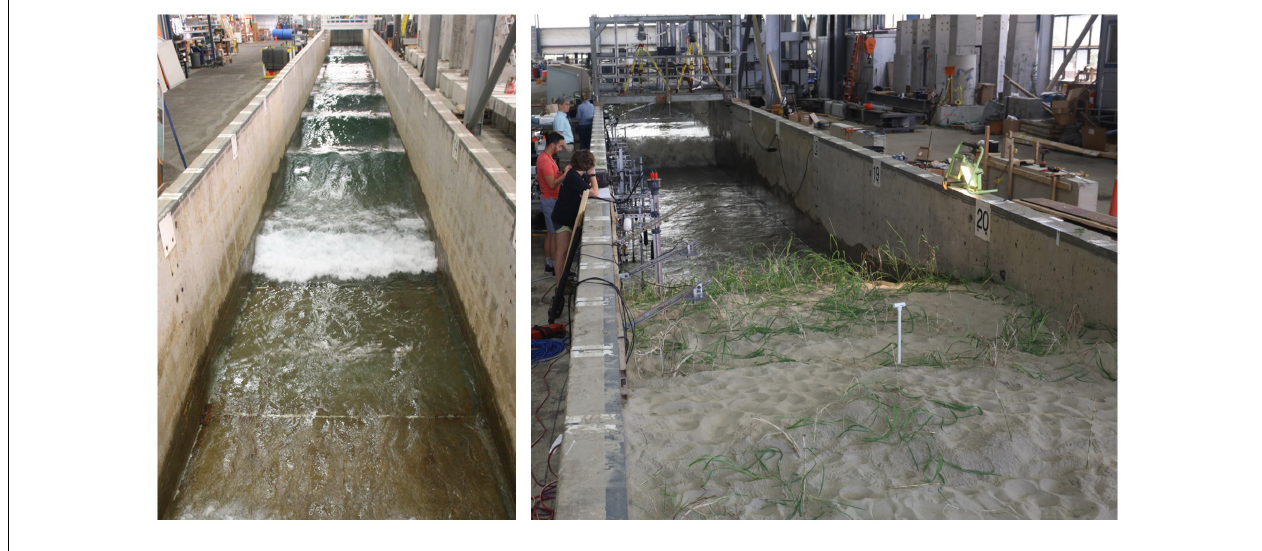
FIGURE 2 | Large Wave Flume overview (left) and use of LWF for dune erosion study (right) .